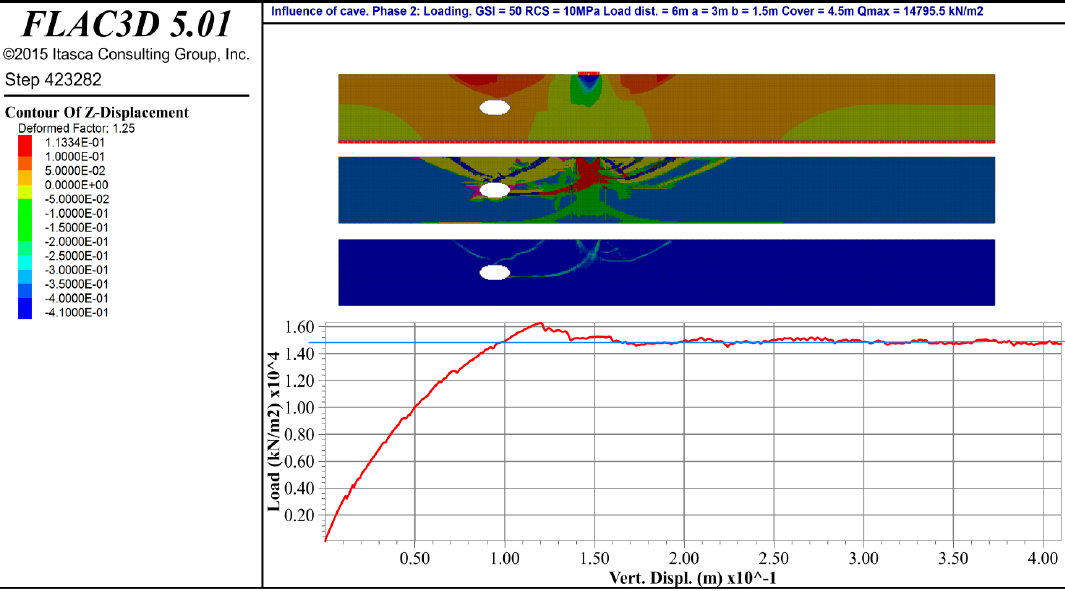
Figure 5. Case IEH-2. Eccentricity E/a = 6 (still a mixed failure mechanism, but with a clear predominance of classic plastic-failure wedge formation on both sides of the footing. Little influence of the cavern).